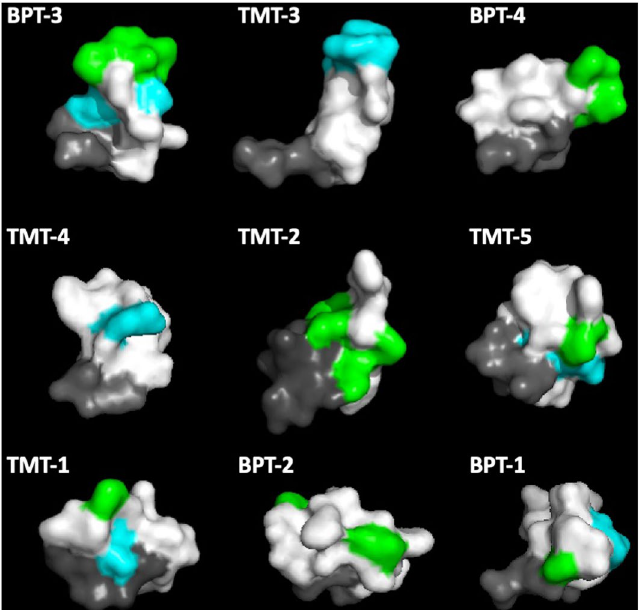
Figure 4. 3-D structures for the nine peptides predicted by PEPFOLD, again arranged in order of transport rate (Table 1) from top left to lower right. The structures are oriented and colored same as in Fig 3. Peptide structures with the highest transport rates display motifs that are exposed at the free end of the peptide. Those with lower transport rates exhibit fewer motif amino acids on their surfaces, and those present tend not to be situated at the pIII free peptide